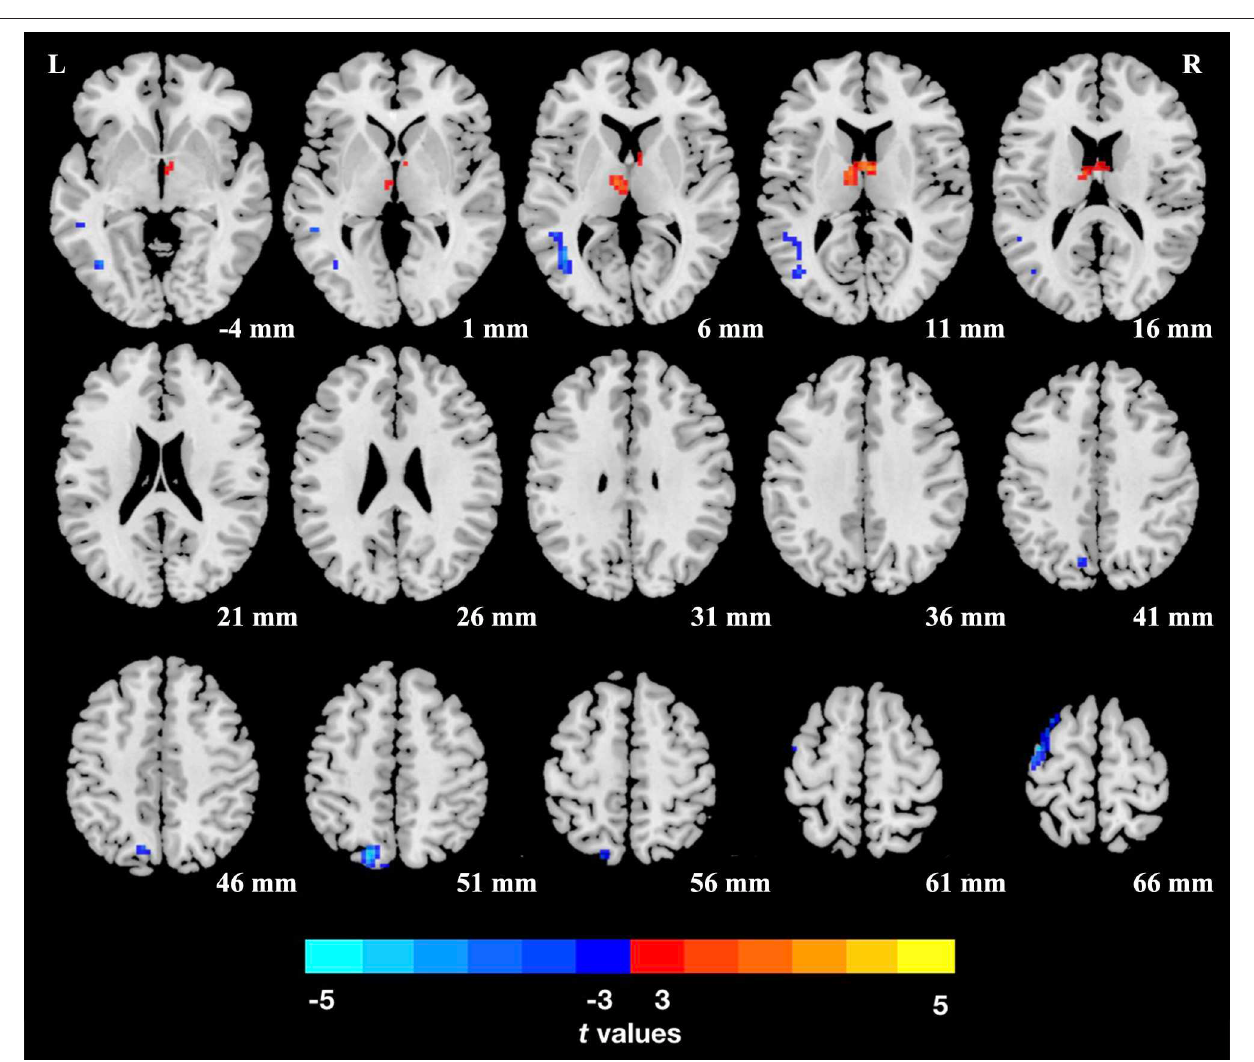
FIGURE 1 | Group differences of dReHo variability were revealed by two-sample t -test. Clusters color-coded in blue (red) indicate significantly decreased (increased) dReHo in the trigeminal neuralgia (TN) patients. L (R), left (right) hemisphere.